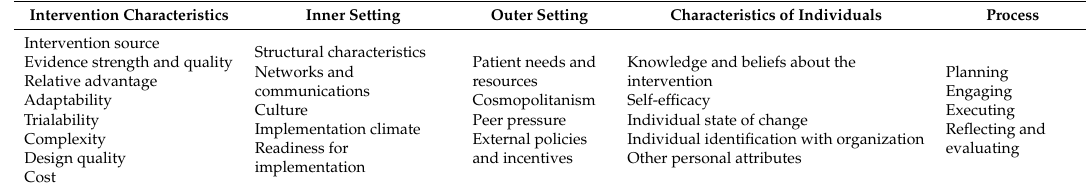
Table 1. Consolidated Framework for Implementation Research (CFIR) Domains and